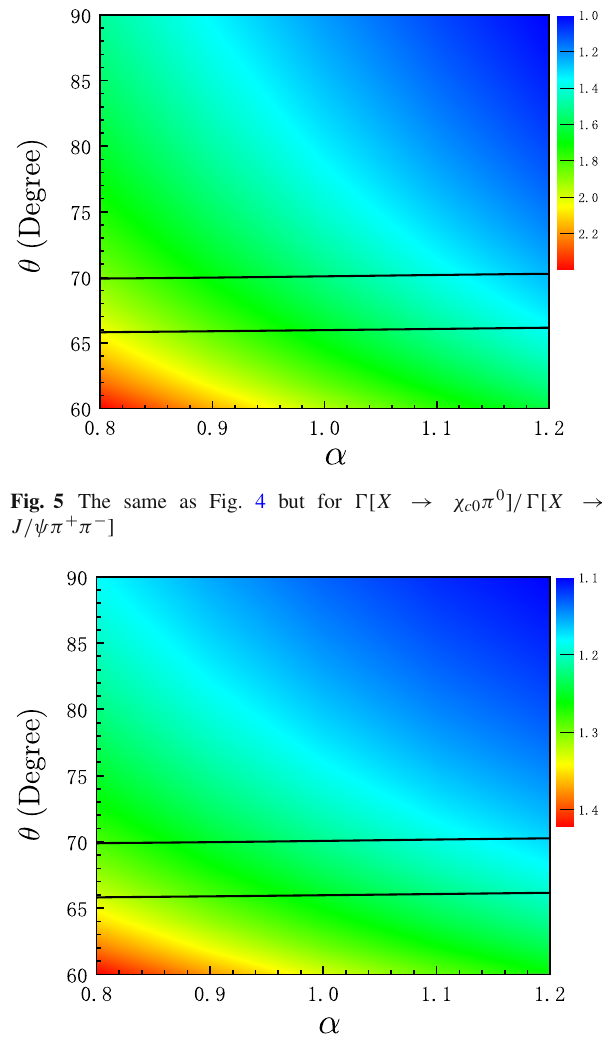
Fig. 6 The same as Fig. 4 but for (cid:5) [ X → χ c 2 π 0 ] /(cid:5) [ X → J /ψπ + π −